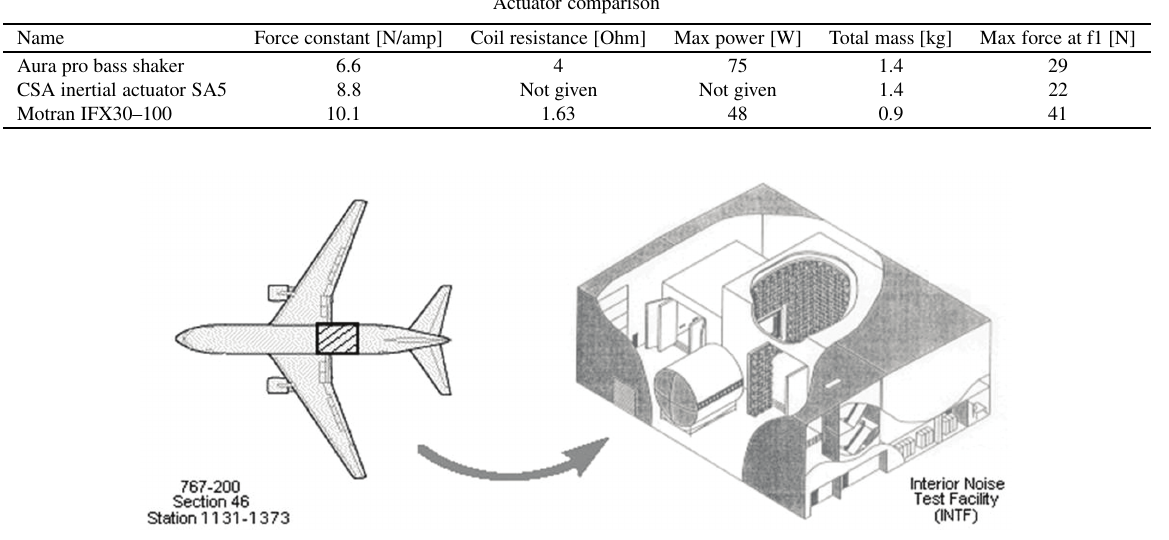
Fig. 7. Diagram of 767 barrel section and interior noise test facility